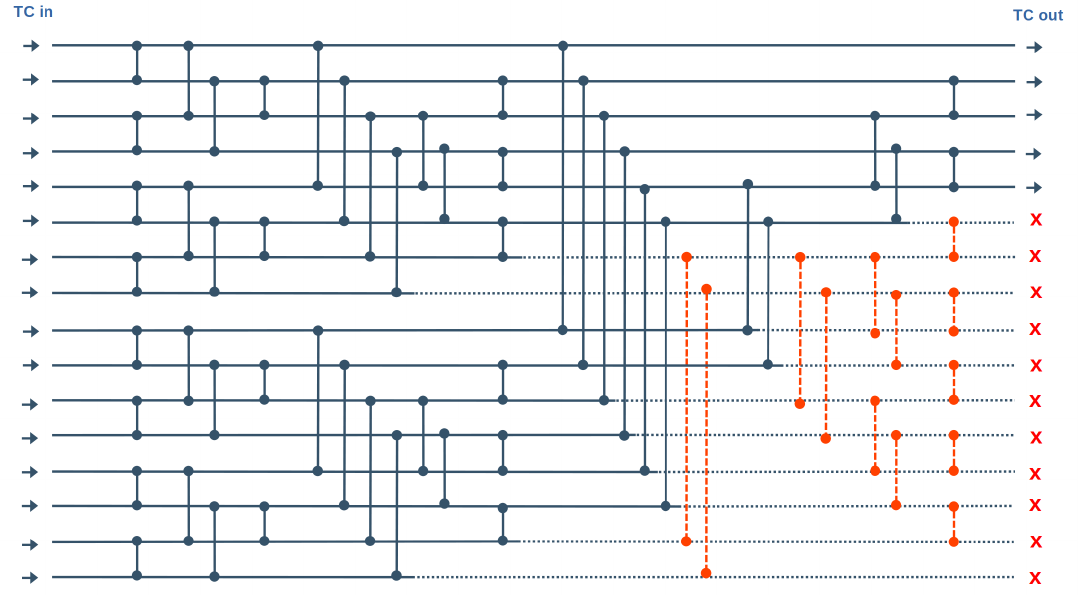
Figure 4. Example of an odd–even mergesort network taking as input the energies of 16 TC and returning the 5 most energetic. The blue vertical links represent comparators in use, where the higher-energy TC is moved up. The dashed red vertical lines represent comparators that are removed to reduce the output